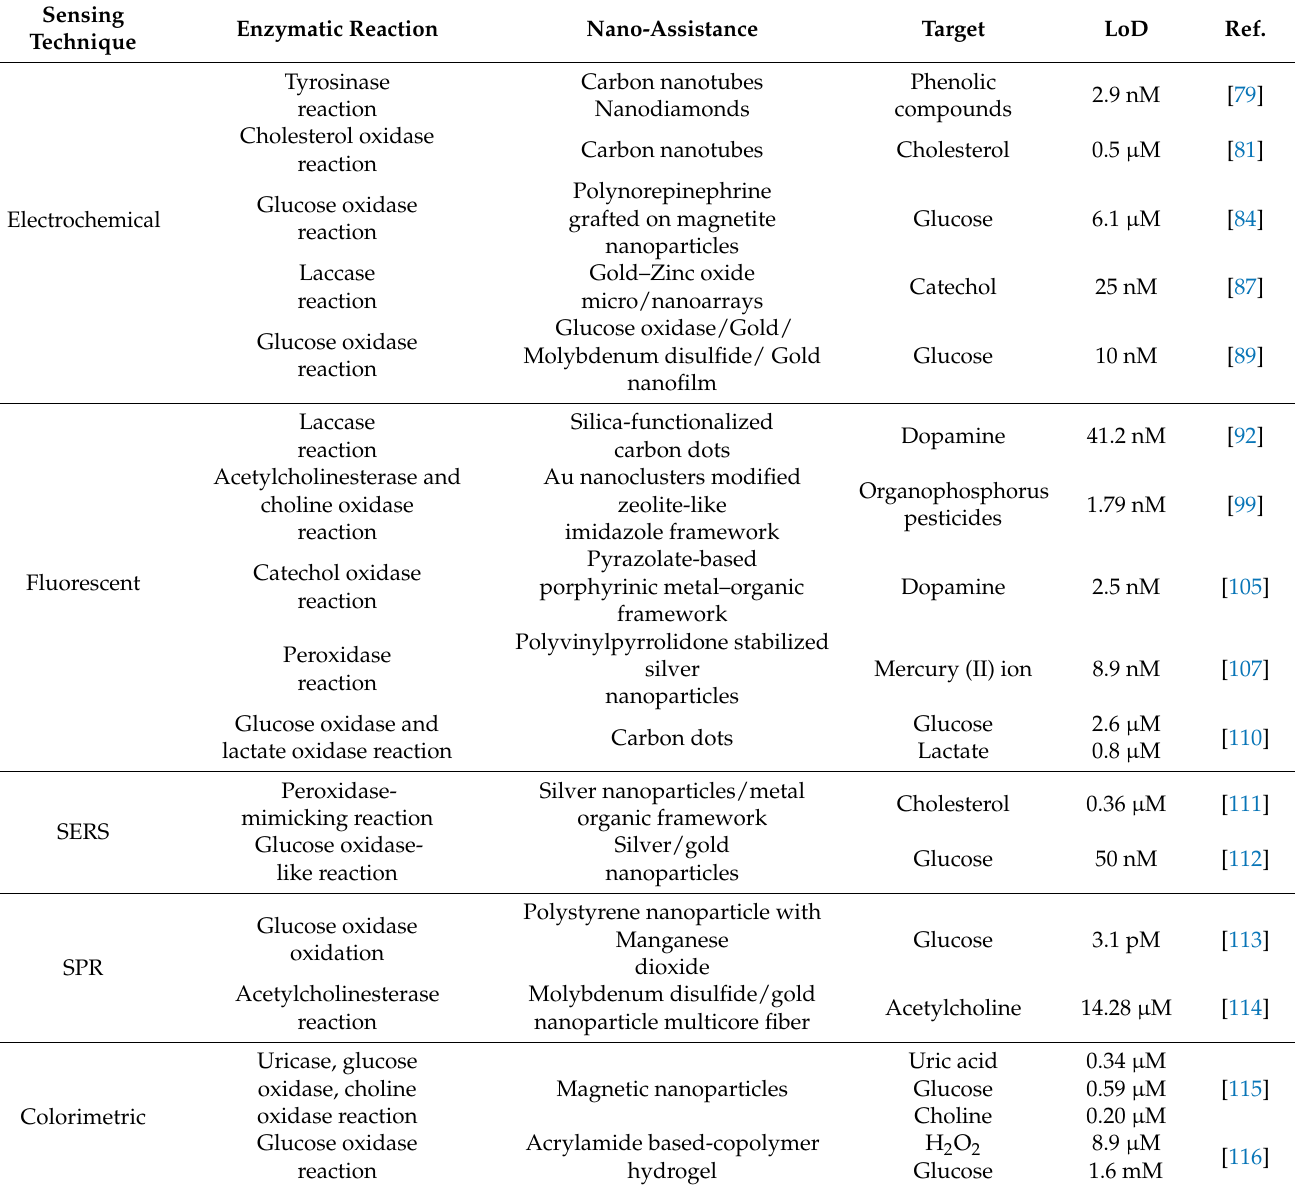
Table 1. The representative electrochemical/fluorescent enzymatic nanobiosensors illustrated in this review and the other enyzamtic nanobiosensors using Surface-enhanced Raman spectroscopy (SERS), Surface plasmon resonance (SPR), and colorimetric